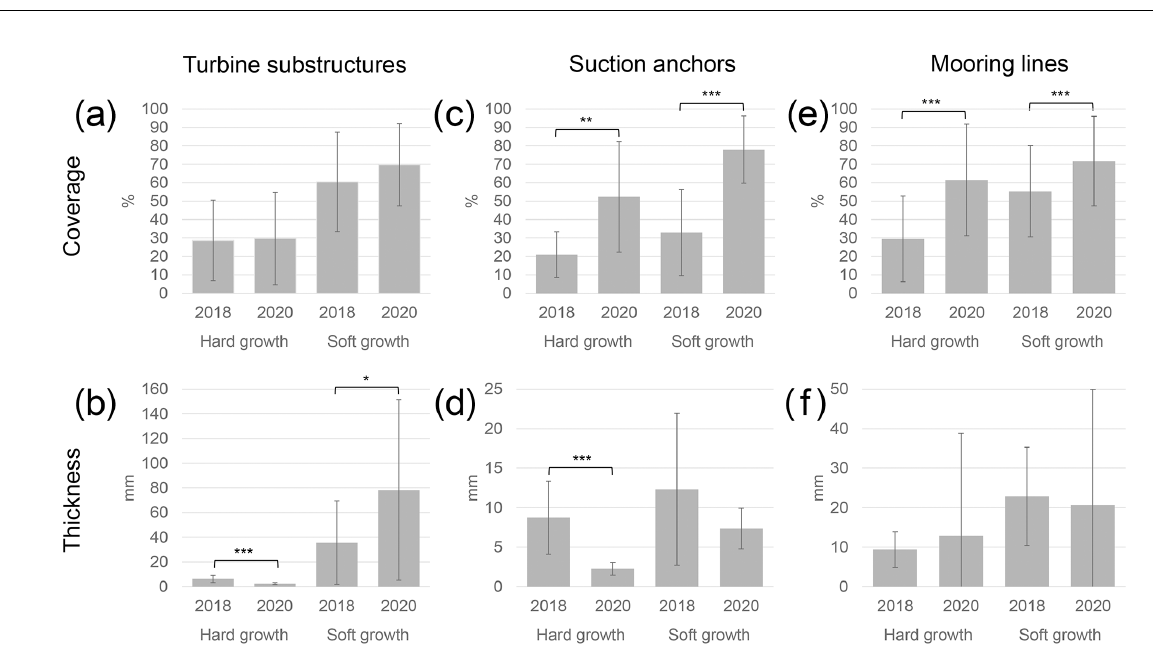
Mooring lines Hard growth